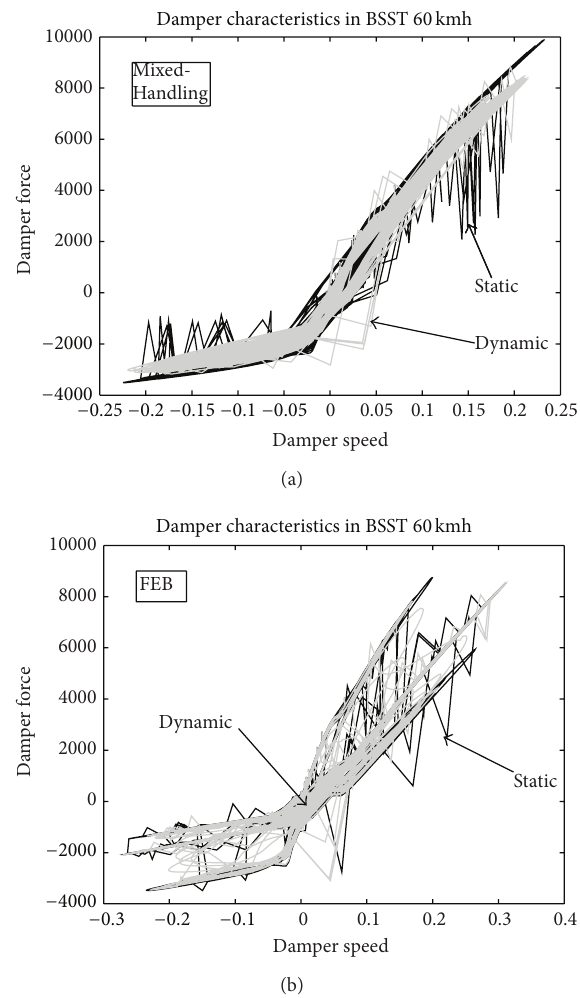
Figure 10: Damper characteristics (static and dynamic) in BSST for constant speed and two controllers.